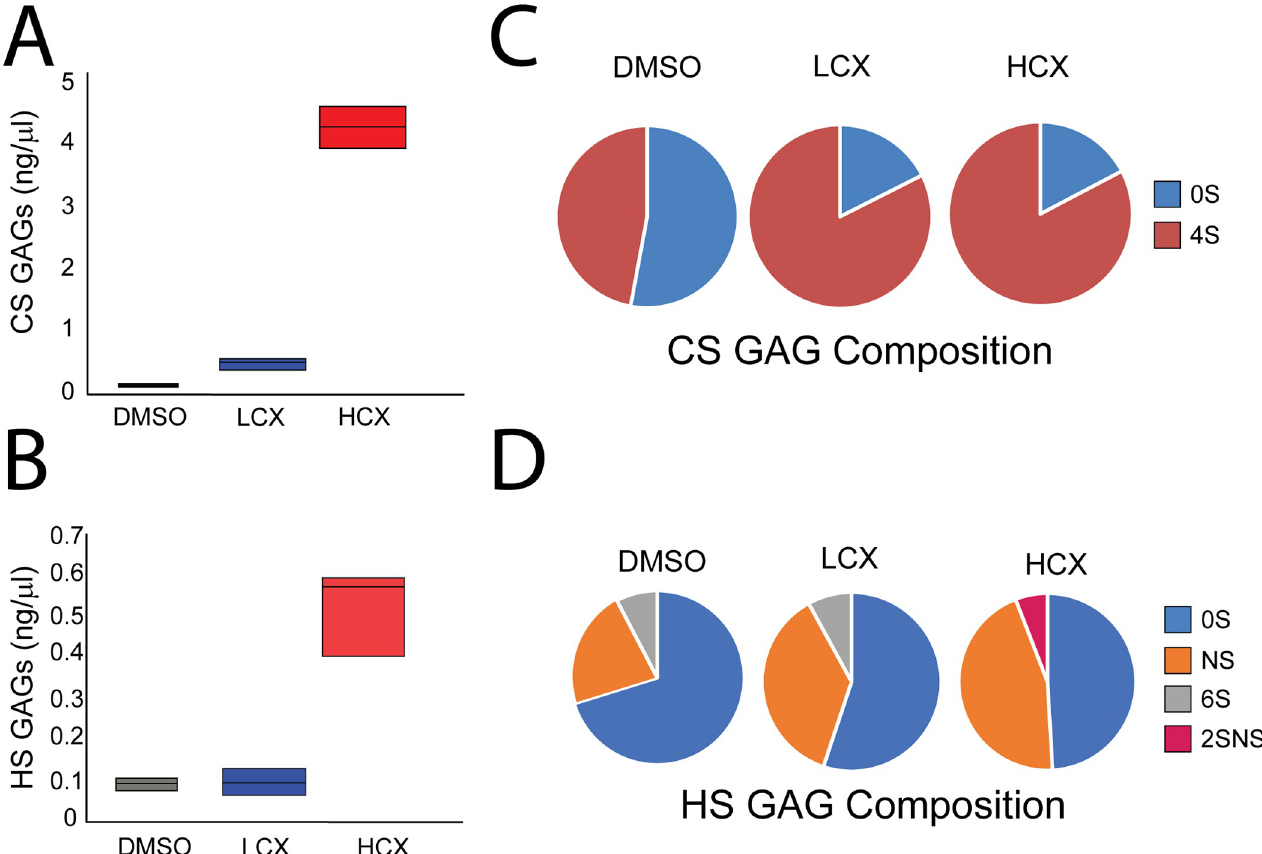
Fig 5. Analysis of glycosaminoglycan chains in conditioned media from Neuro2a cells after xyloside treatment. GAG chains were collected from conditioned medium and subject to analysis of total GAG levels as well as disaccharide composition, expressed as percentage of total GAGs. A) Quantification of CS GAG levels present in conditioned media sample. B) CS disaccharides analysis. 0S, Δ HexUA-GalNAc; 4S, Δ HexUA-GalNAc(4- O -sulfate). C) Quantification of HS GAG levels present in conditioned media sample. D) HS disaccharide analysis. 0S, Δ HexUA-GlcNH 2 ; NS, Δ HexUA-GlcNS; 6S, Δ HexUA-GlcNH 2 (6- O -sulfate); 2SNS, Δ HexUA(2- O